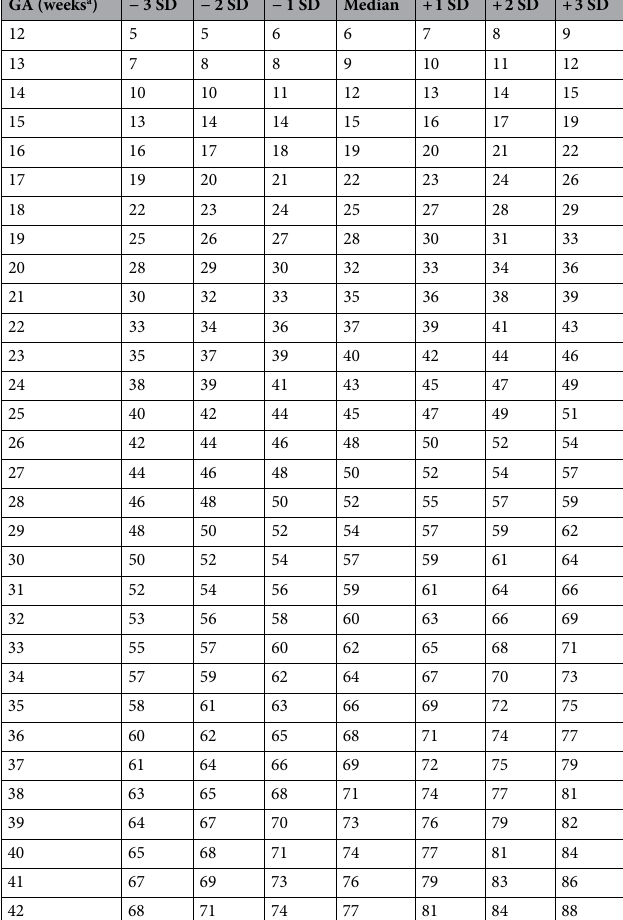
Table 10. Estimated femur length (FL) in mm by gestational age (GA) for males and females, standard deviations (SD). a GA expressed as completed gestational weeks, e.g. 12 weeks corresponds to 12 + 0 weeks or 84 gestational